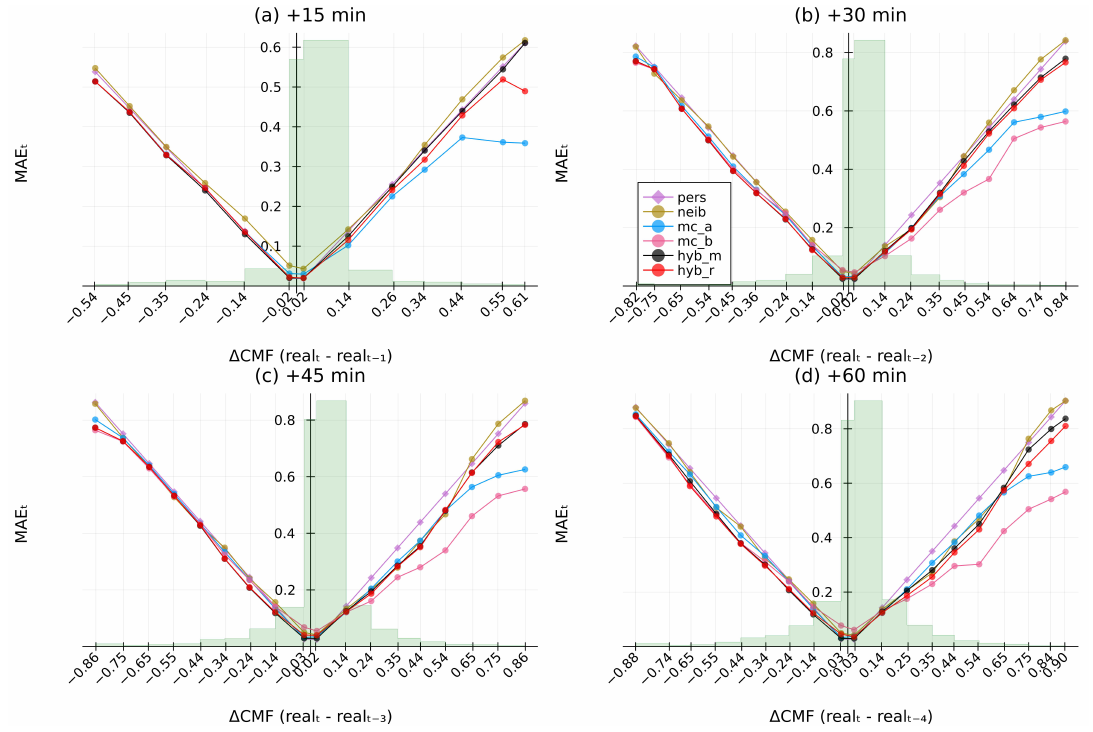
Figure A7. MAE of CMF change for ( a ) 15 min, ( b ) 30 min, ( c ) 45 min, and ( d ) 60 min ahead for Athens.